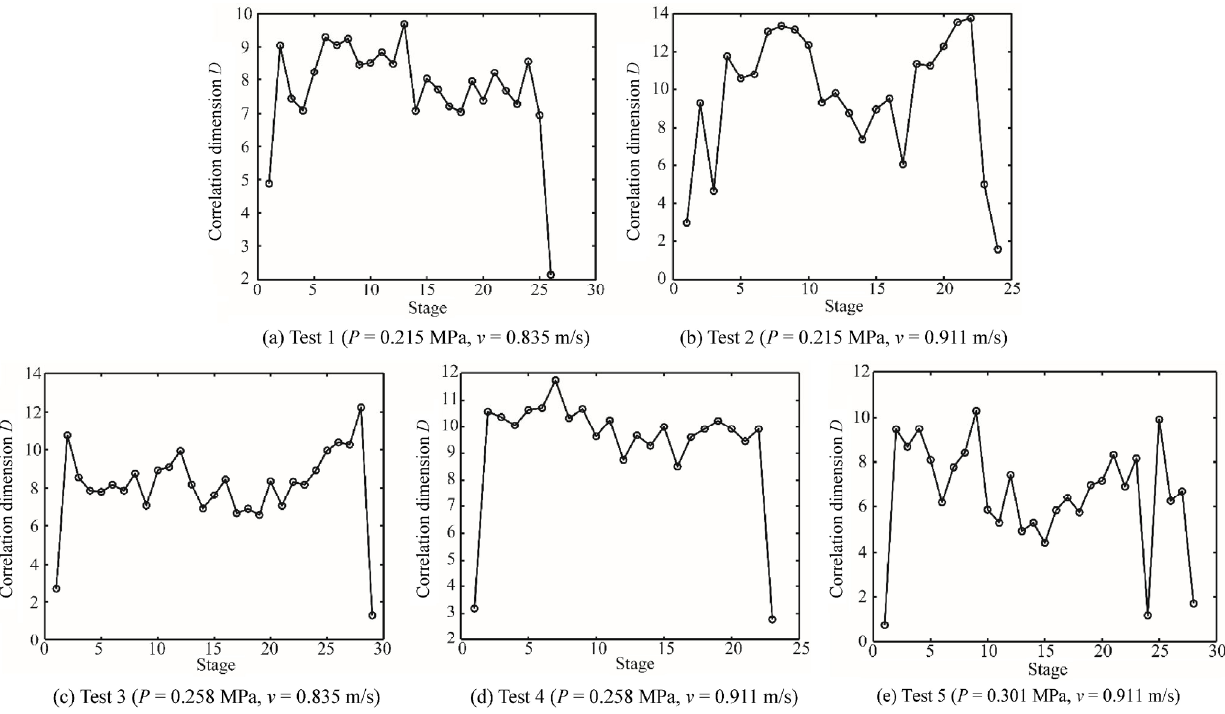
Fig. 9 Correlation dimensions of friction noise in the wear